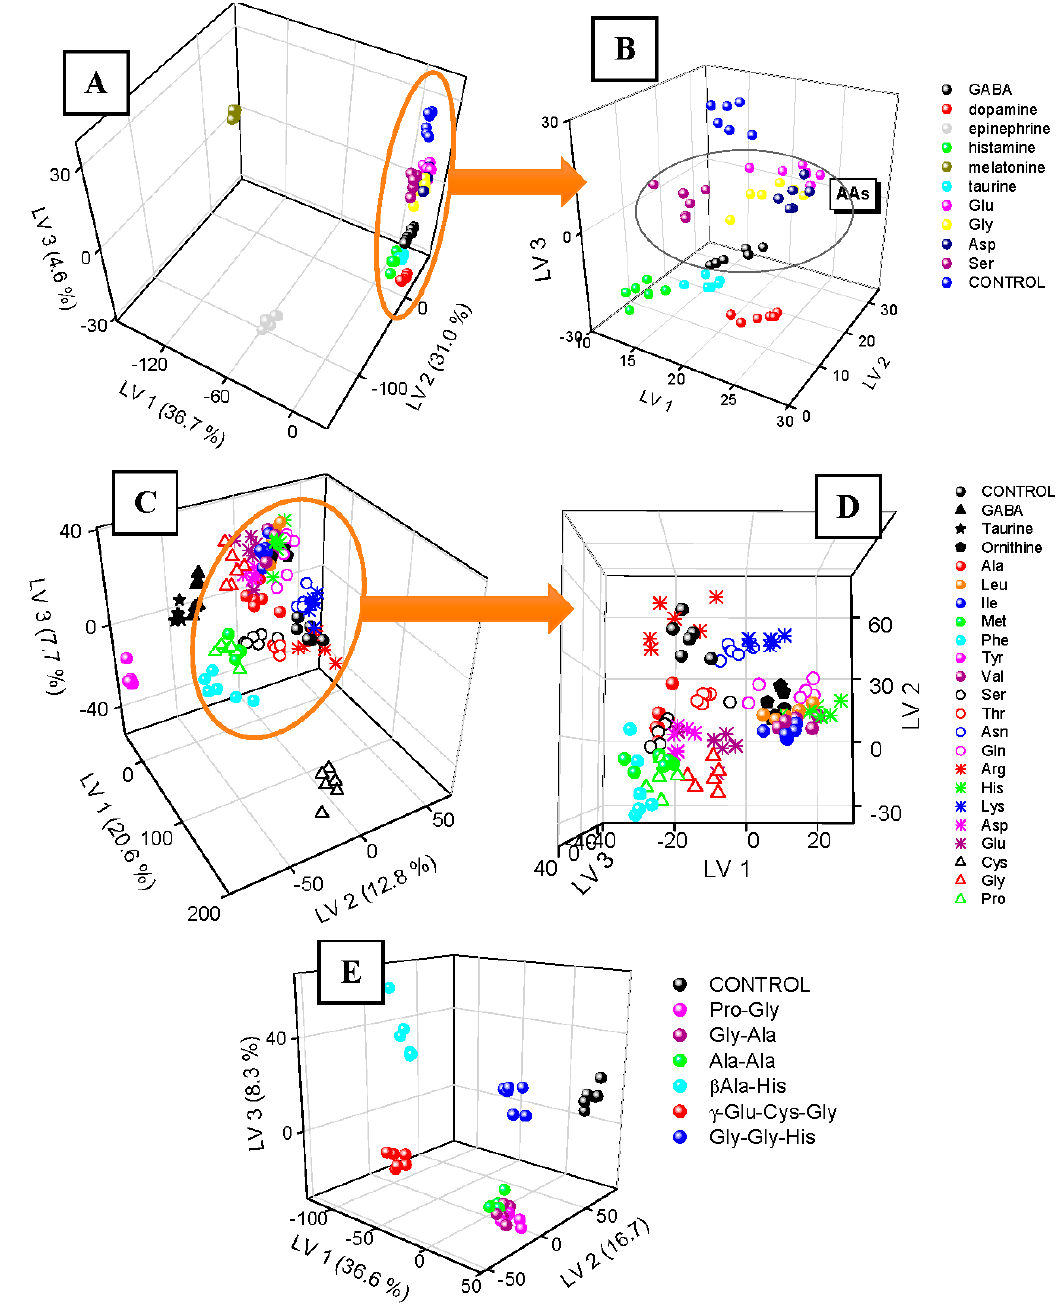
Figure 2. PLS-DA score plot for identification of neurotransmitters ( A , B ), amino acids ( C , D ) and oligopeptides ( E ).